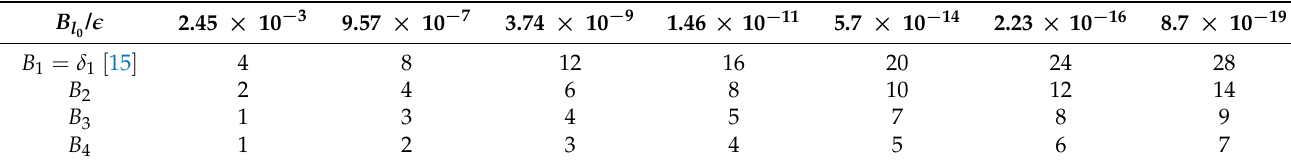
Table 2. Depth of a 3-point approximating QSS curve model.